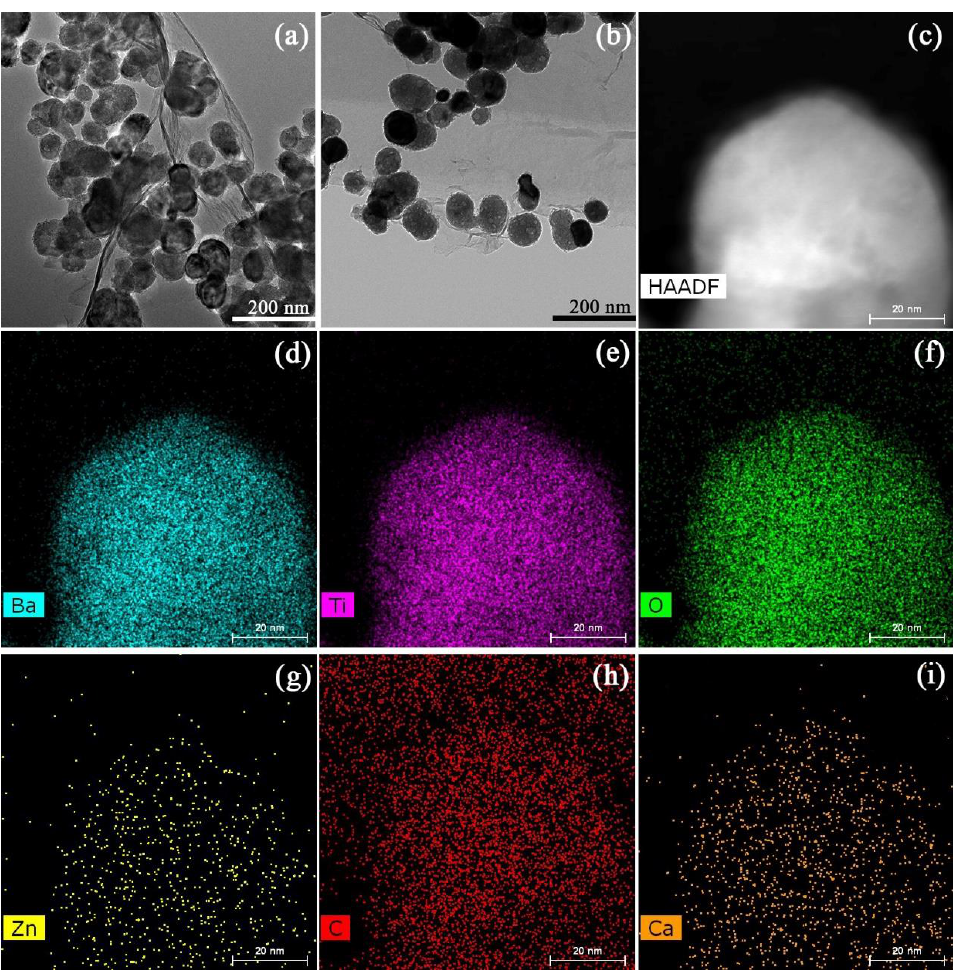
Figure 2. ( a ) Transmission electron microscope (TEM) image of BT@ZnPc-GO-1, ( b ) TEM image of BT@ZnPc-GO-2. ( c ) STEM images of BT@ZnPc-GO-1. EDS mapping images of ( d ) Ba, ( e ) Ti, ( f ) O, ( g ) Zn, ( h ) C and ( i ) Ca.